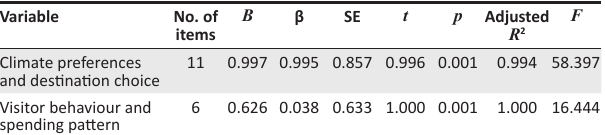
TABLE 4: Linear regression analysis results.